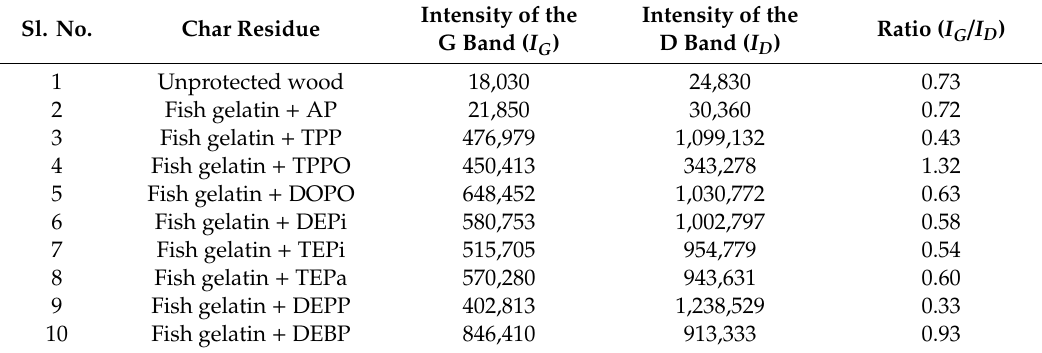
Table 3. Details of Raman spectra of char